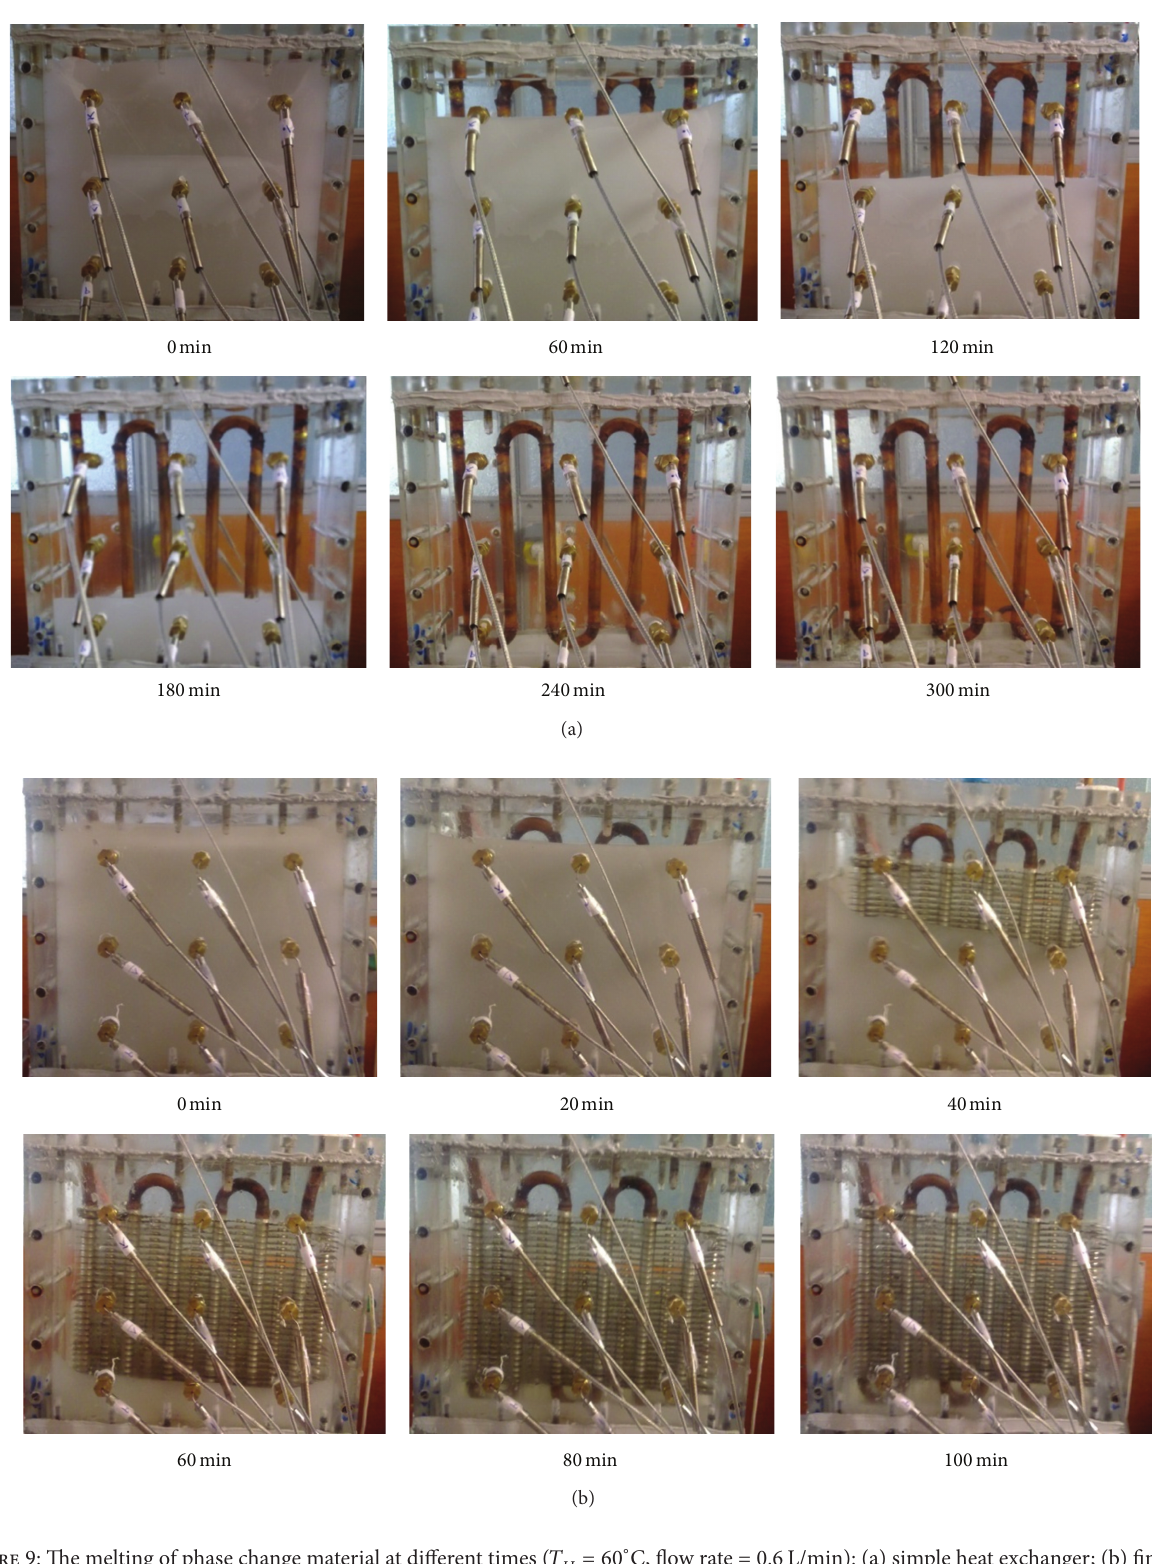
Figure 9: The melting of phase change material at different times ( 𝑇 𝐻 = 60 ∘ C, flow rate = 0.6 L/min): (a) simple heat exchanger; (b) finned- tube heat